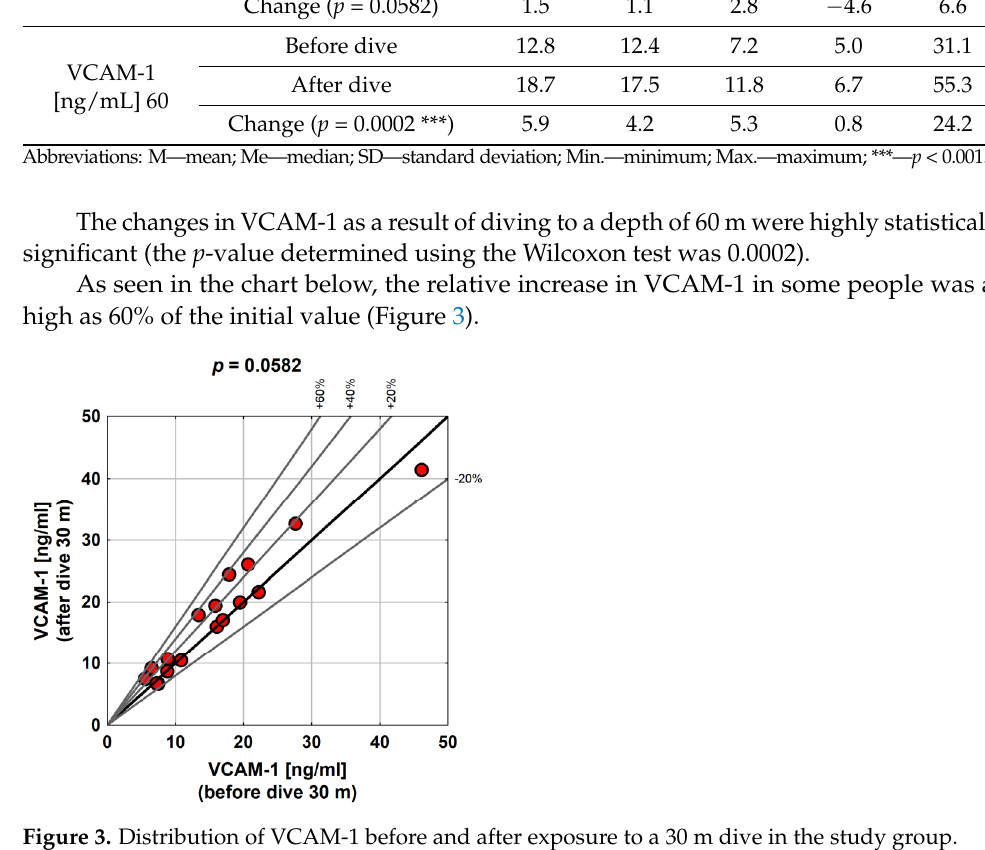
Table 5. Distribution of VCAM-1 before and after the exposure corresponding to a 30 m and 60 m dive in the divers group.